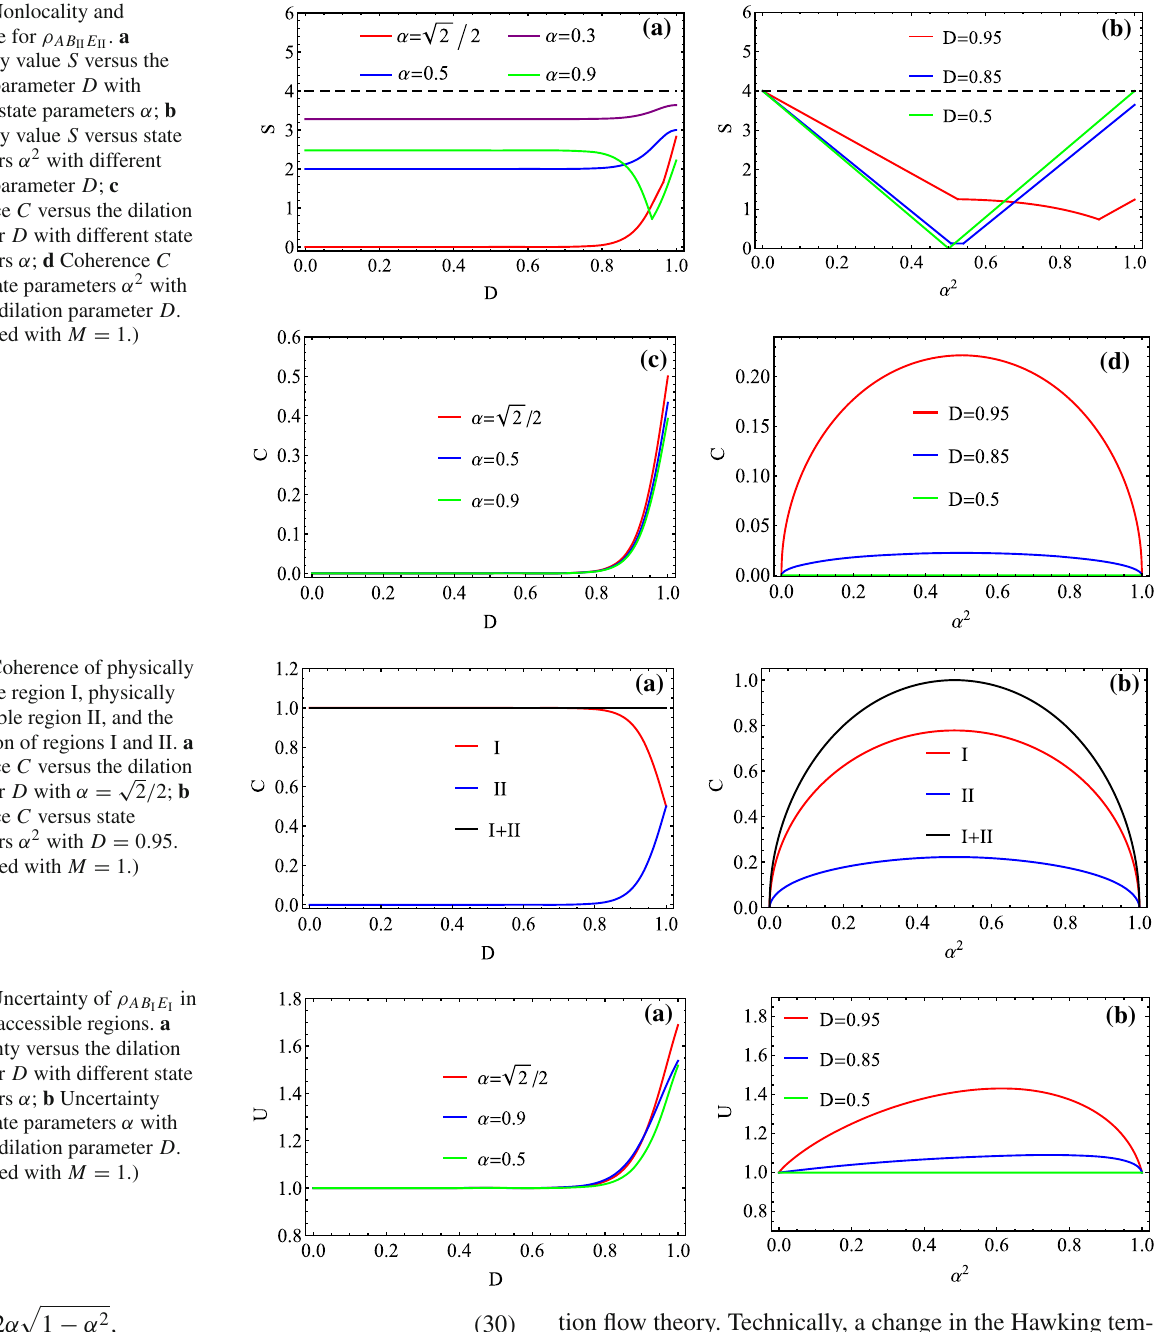
Fig. 4 Uncertainty of ρ AB physical accessible regions. a Uncertainty versus the dilation parameter D with different state parameters α ; b Uncertainty versus state parameters α with different dilation parameter D . (All plotted with M =